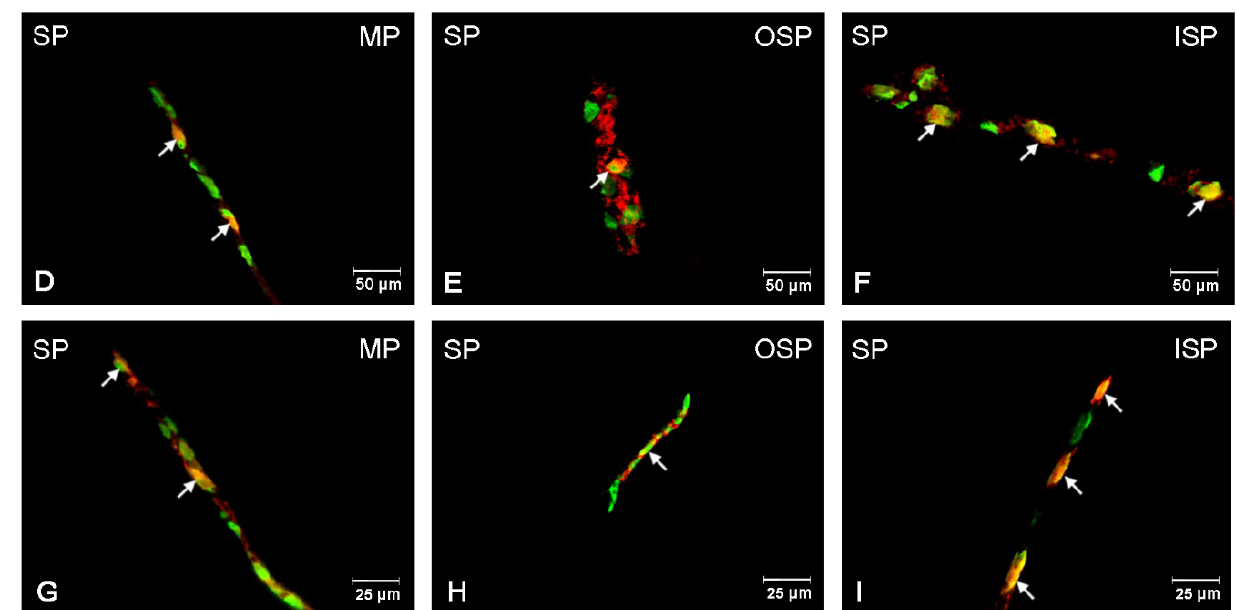
Figure 10. Fluorescence microscopy images showing protein gene product 9.5 (PGP 9.5) visible as